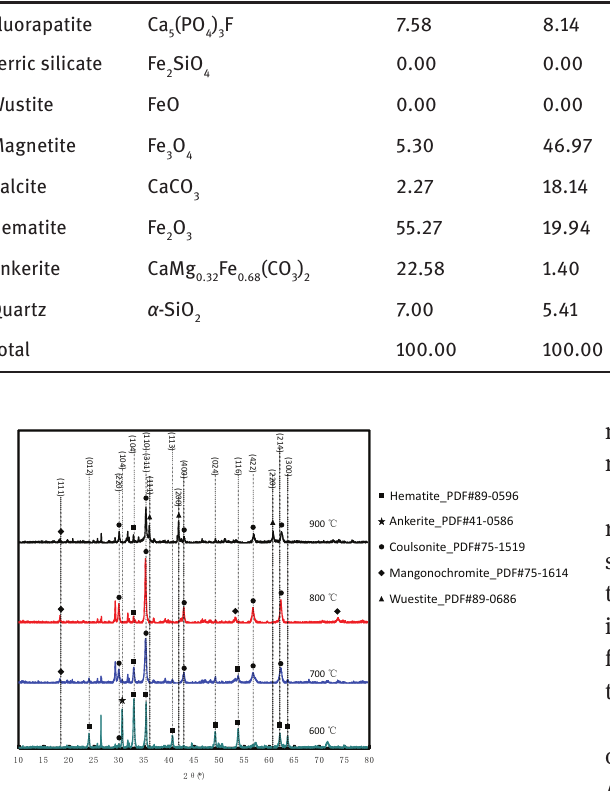
Table 5: Amount (%) of mineral phase during the roasting process at different temperatures. Mineral